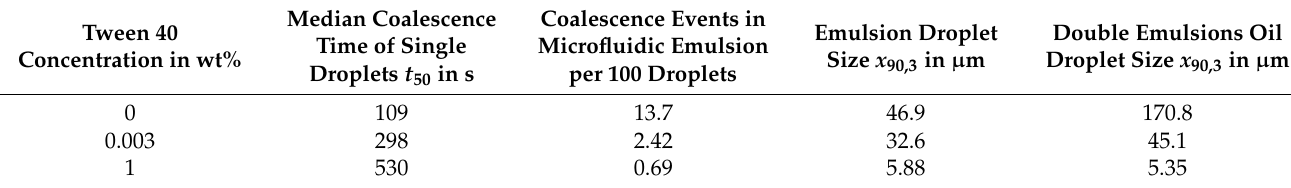
Table 2. Comparison of the effects of the three different measurement methods on the different Tween 40 concentrations with addition of PGPR. For the microfluidic experiment, the values after one day for the emulsification experiments directly after production are